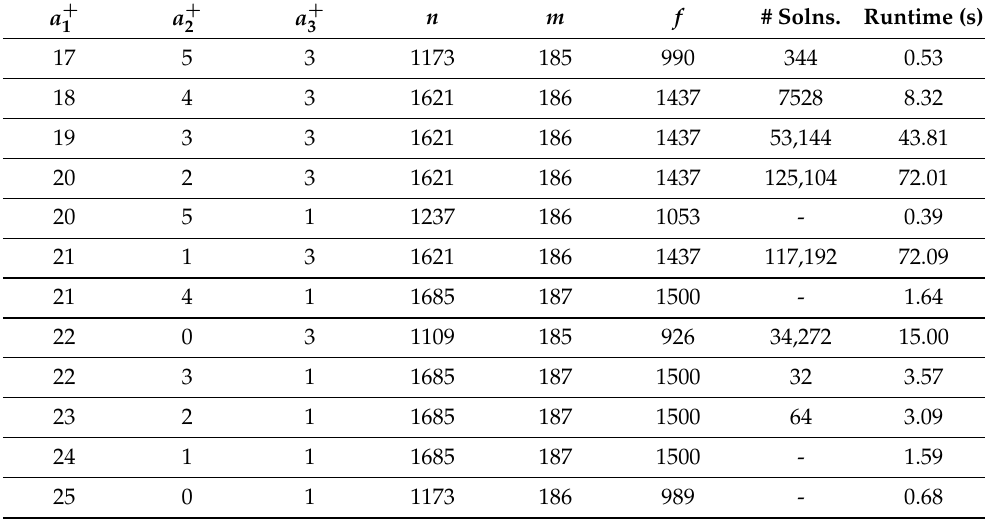
Table 4. Number of tiling solutions (# solns.) and runtimes in seconds for CPLEX to solve the 12 pariomino tiling subproblems in Example